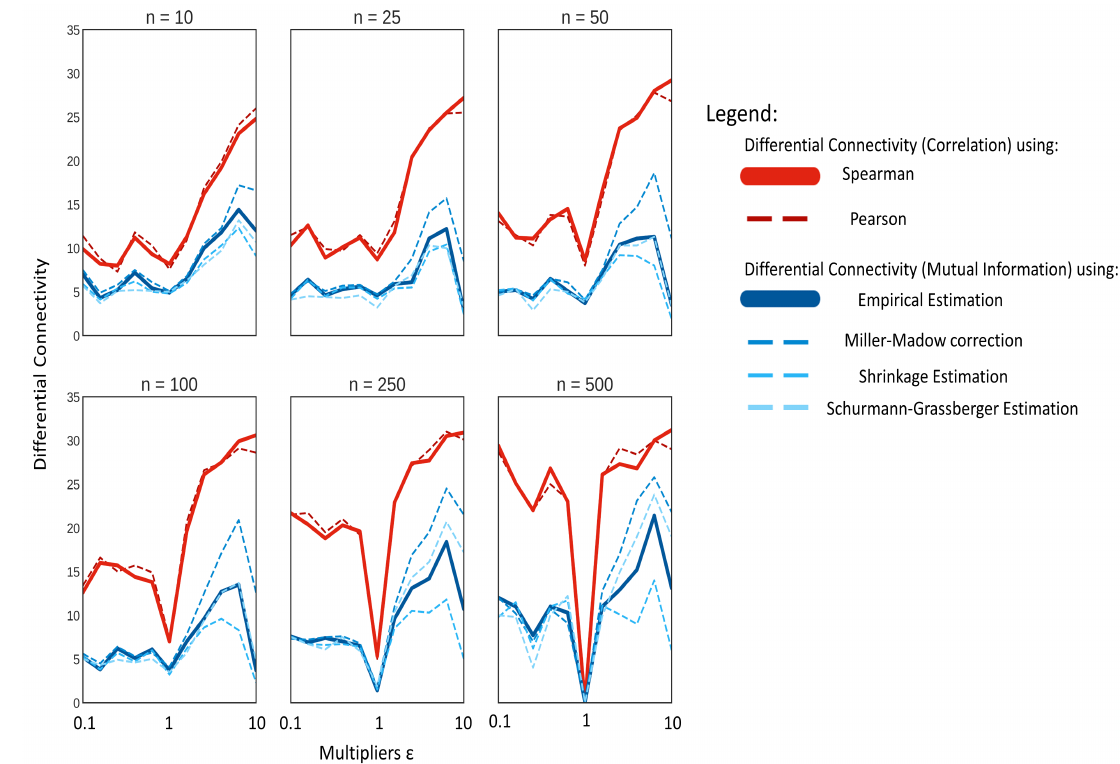
Figure 7. Median of the significant differentially connected variables on data simulated using the NF- κ B dynamic model as a function of the model perturbation (cid:101) and the sample size n